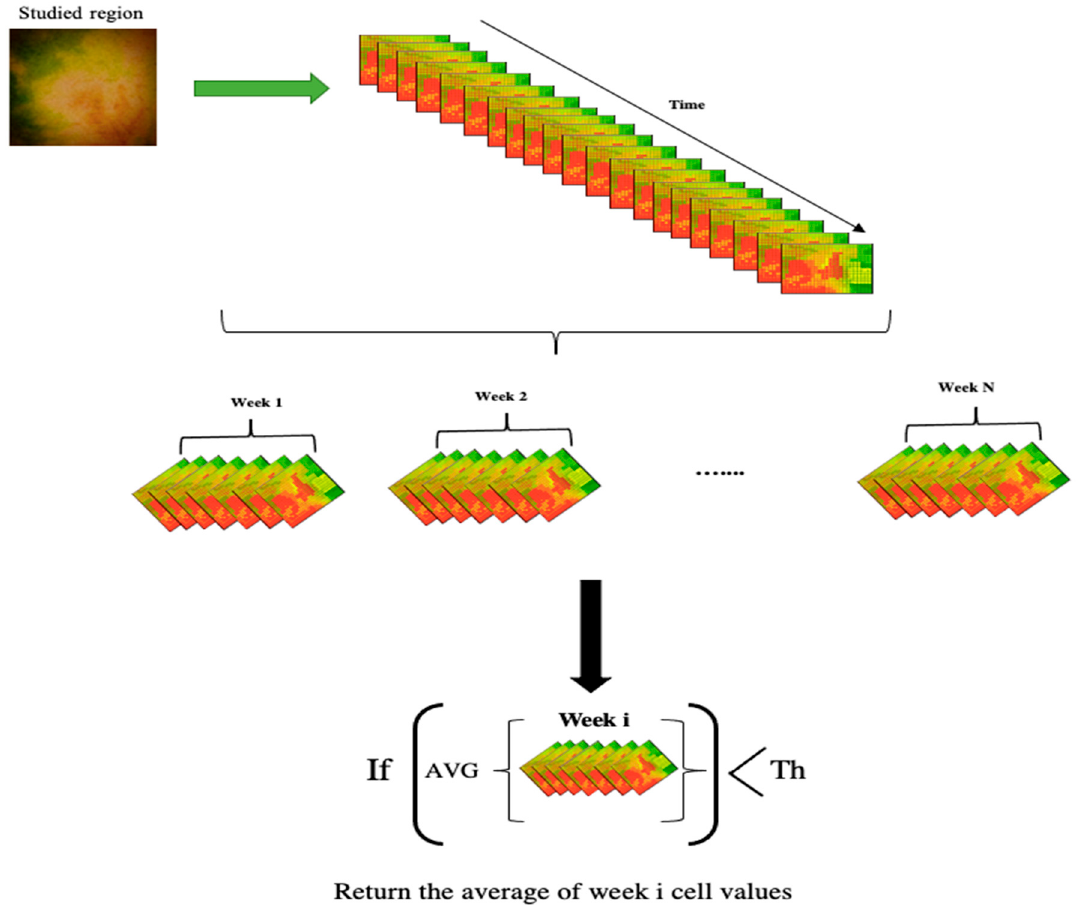
Figure 3. Overall framework for the query process .